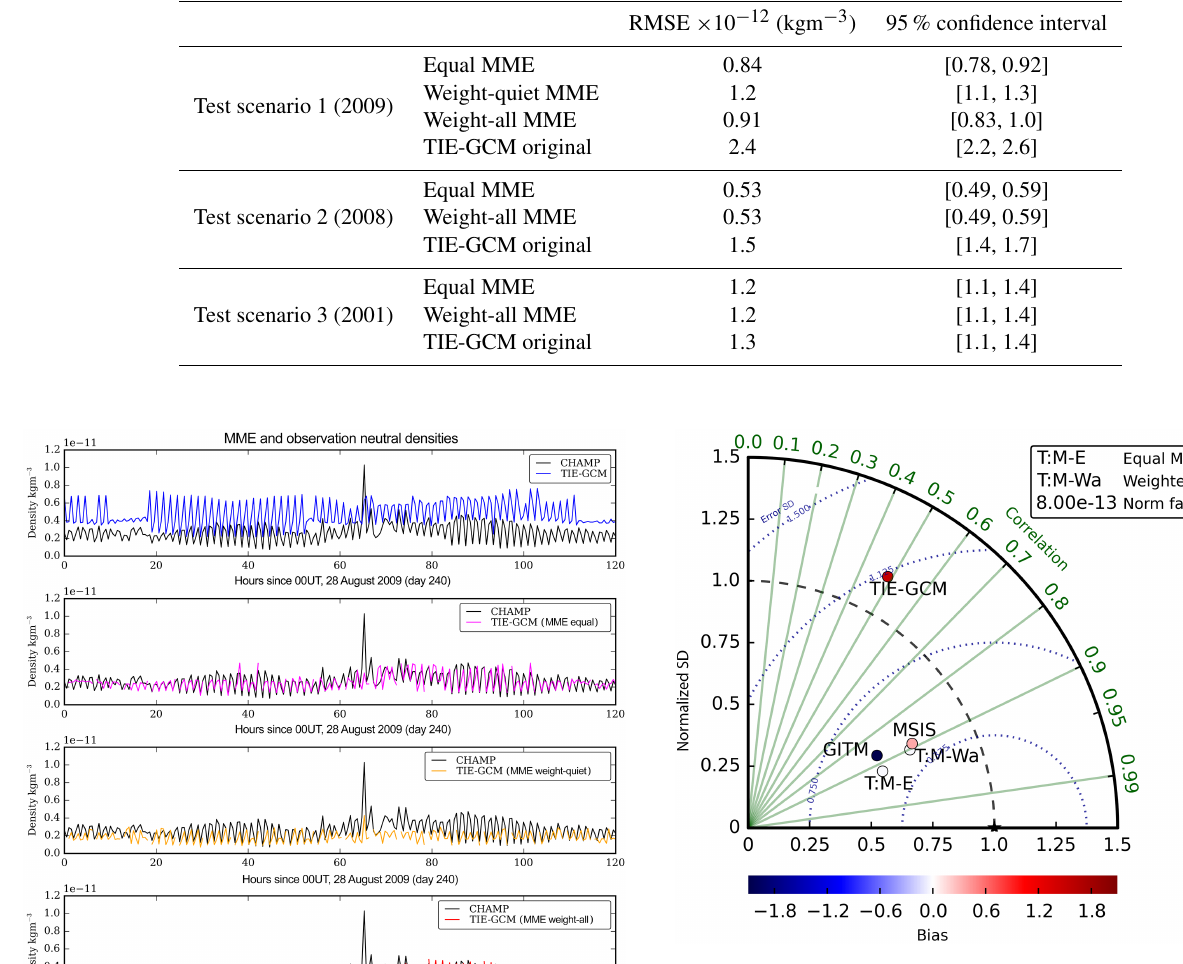
Figure 17. Modified Taylor diagram for NRLMSISE-00 (MSIS), TIE-GCM, GITM, and for TIE-GCM using the MMEs (equal and all-time weighted) for its initial conditions every 6h, compared with the CHAMP observations. Details of how to read the diagram are described in Fig.